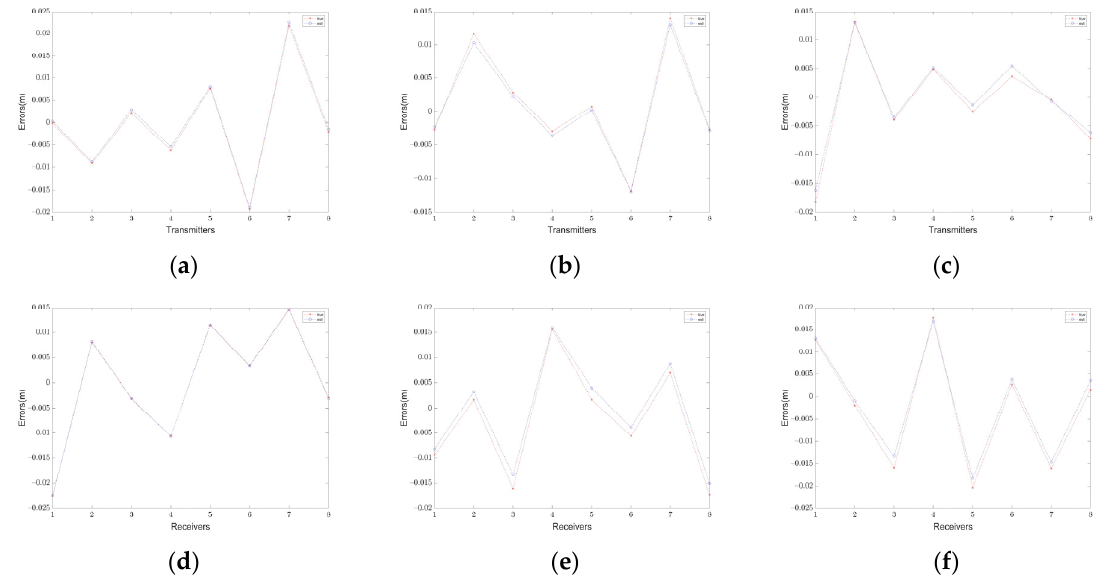
Figure 4. MIMO array motion errors estimation. ( a ) x dimension of Transmitters. ( b ) y dimension of Transmitters. ( c ) z dimension of Transmitters. ( d ) x dimension of Receivers. ( e ) y dimension of Receivers. ( f ) z dimension of Receivers.